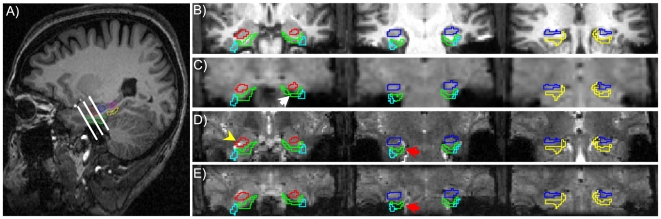
Distortion and signal loss due to through-slice dephasing are evident in the most anterior regions of parahippocampal gyrus (PHG), while the posterior half of the hippocampus (HIPP) and PHG are unaffected by susceptibility artifacts.(A) Location of slices and ROIs for a representative subject, shown on parasagittal section of the reference anatomy (3D MP-RAGE). (B) Three slices resampled from reference anatomy in anterior MTL to match location and resolution of functional data (zoomed EPI). Red and blue regions of interest are anterior and middle hippocampus; cyan (PR), green (ER) and yellow (pPHG) regions of interest are parahippocampal gyrus. (C) Low resolution EPI acquisition. Thicker slices (3 mm) result in increased signal loss due to through-slice dephasing in PHG (white arrow). (D) High-resolution full FOV EPI images. In the most anterior slice, field gradients in the hippocampus displace signal so the ventricle, rather than the hippocampus, is in the selected region of interest (yellow arrow). Similarly, PHG ROIs contain signal from HIPP (red arrow), and PHG signal is lost. (E) Zoomed high-resolution EPI images. Signal is lost only in anterior PHG (ER and PR); distortion is negligible.